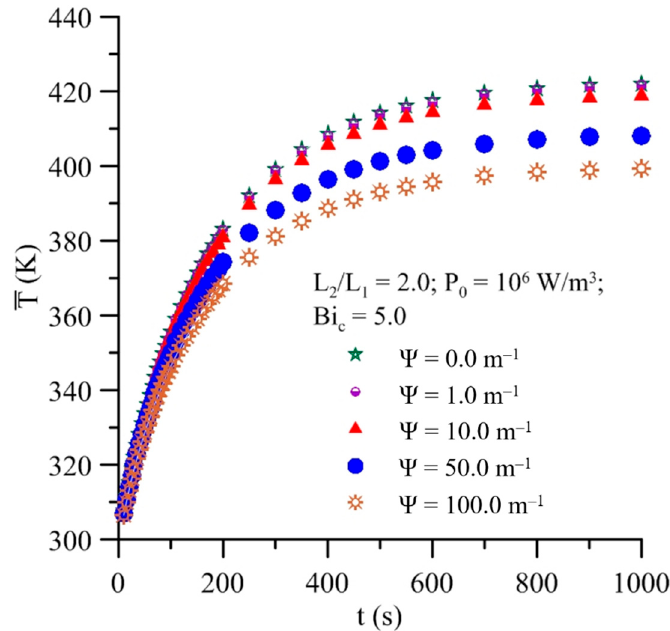
Figure 15. Transient behavior of the average temperature inside a prolate spheroidal solid with aspect ratio L 2 /L 1 = 2.0 for different attenuation factors and fixed microwave power density and heat transfer Biot number.